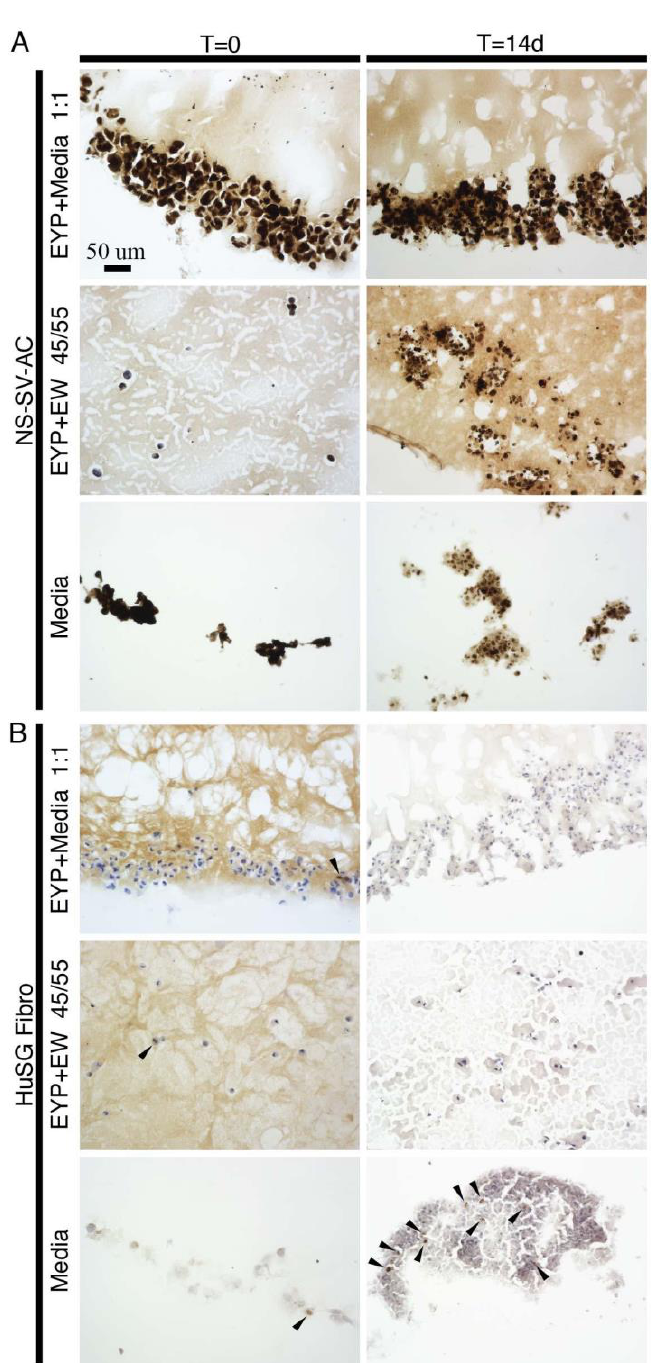
Figure 2. NS-SV-AC and HuSG Fibro cells in EYP biomaterial combinations and media analyzed at times 0 and 14 days with Ki-67 antibody using immunohistochemistry. Tissue sections were obtained